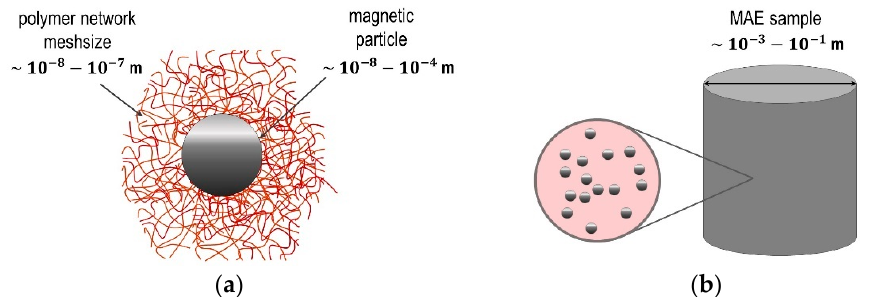
Figure 2. Schematic representation of MAE’s multiscale structure: ( a ) a magnetic particle in a polymer matrix resolved at the nanoscale; ( b ) a macroscopic MAE sample with a random distribution of magnetic particles in a viscoelastic medium.